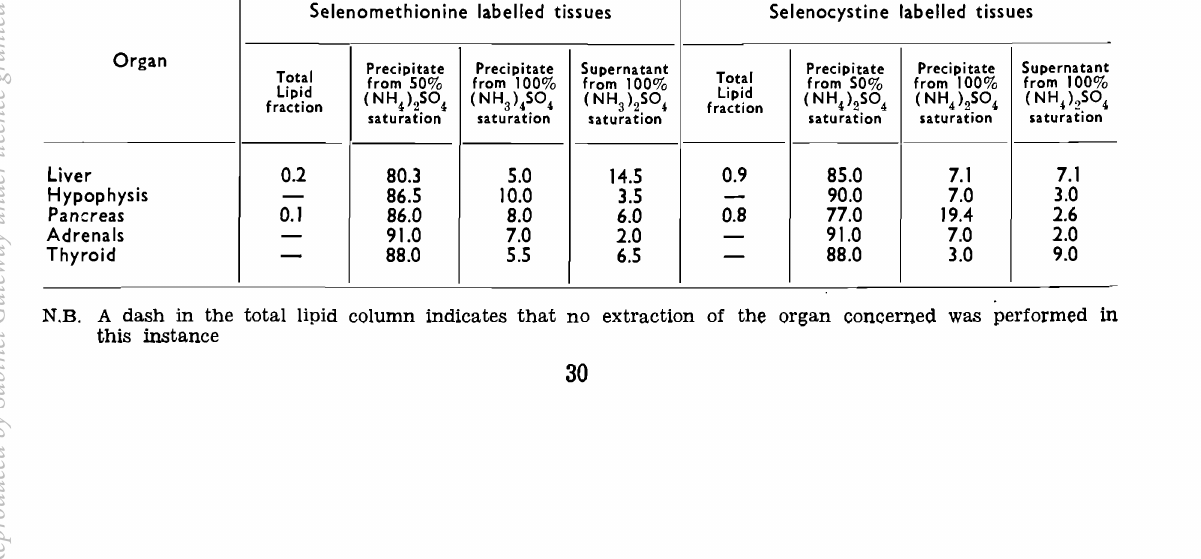
Table 4: DISTRIBUTION OF RADIOACTIVITY IN VARIOUS FRACTIONS OF SOME OTHER BODY TI~SUES Selenomethionine labelled tissues Organ Precipitate